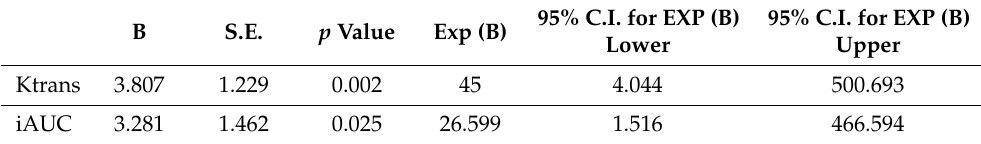
Table 7. Logistic regression for estimating the probability occurrence of poorly differentiated (G3)